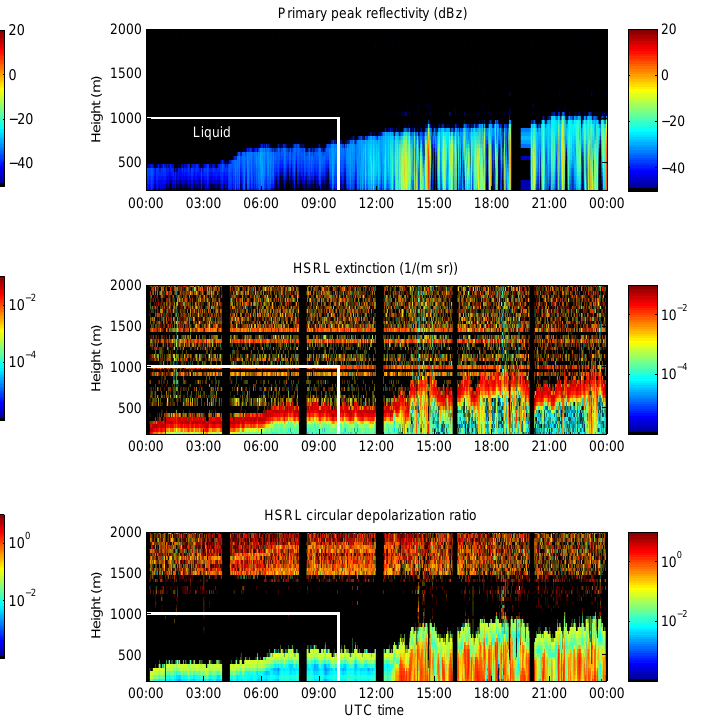
Figure 6. As in Fig. 5, but for 1 October 2004. White outlined area shows ice cloud.